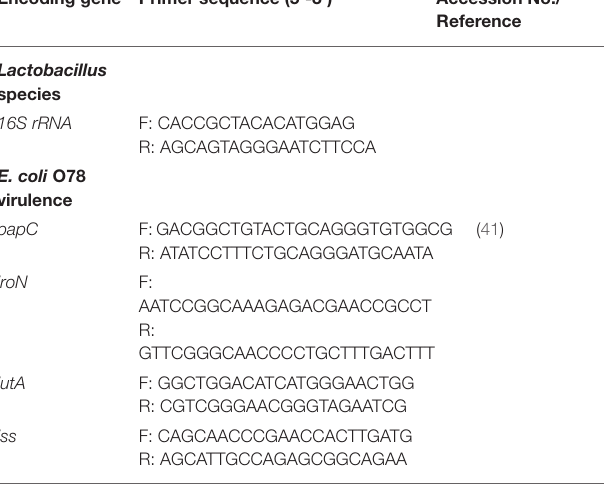
TABLE 3 | Effects of dietary supplementation of various levels of eugenol nanoemulsion on growth performance parameters of broilers challenged with E. coli O78 at 14 days of